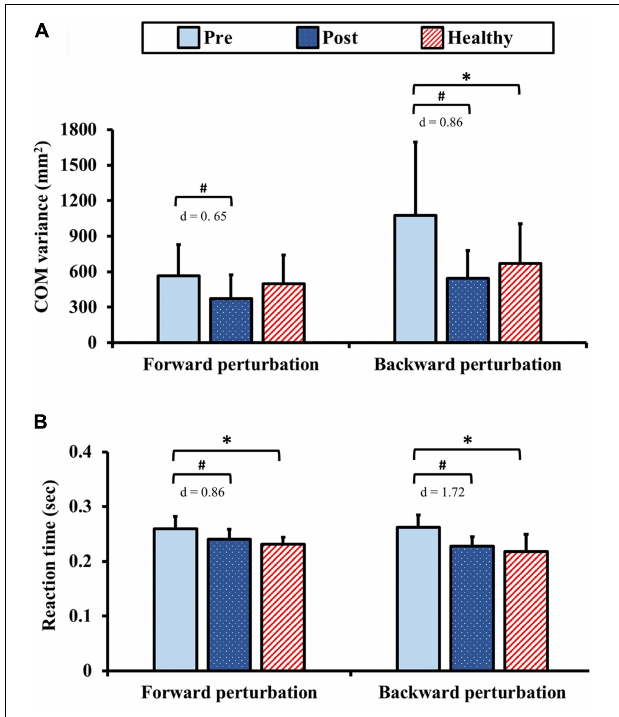
FIGURE 6 | Results for dynamic postural control: (A) center of mass (COM) variance and (B) reaction time during standing with perturbation. The symbol “ ∗ ” indicated a significant difference between the DCM group and the healthy control group: p < 0.05. The symbol “#” indicated a significant difference in the DCM group before and after training: p <